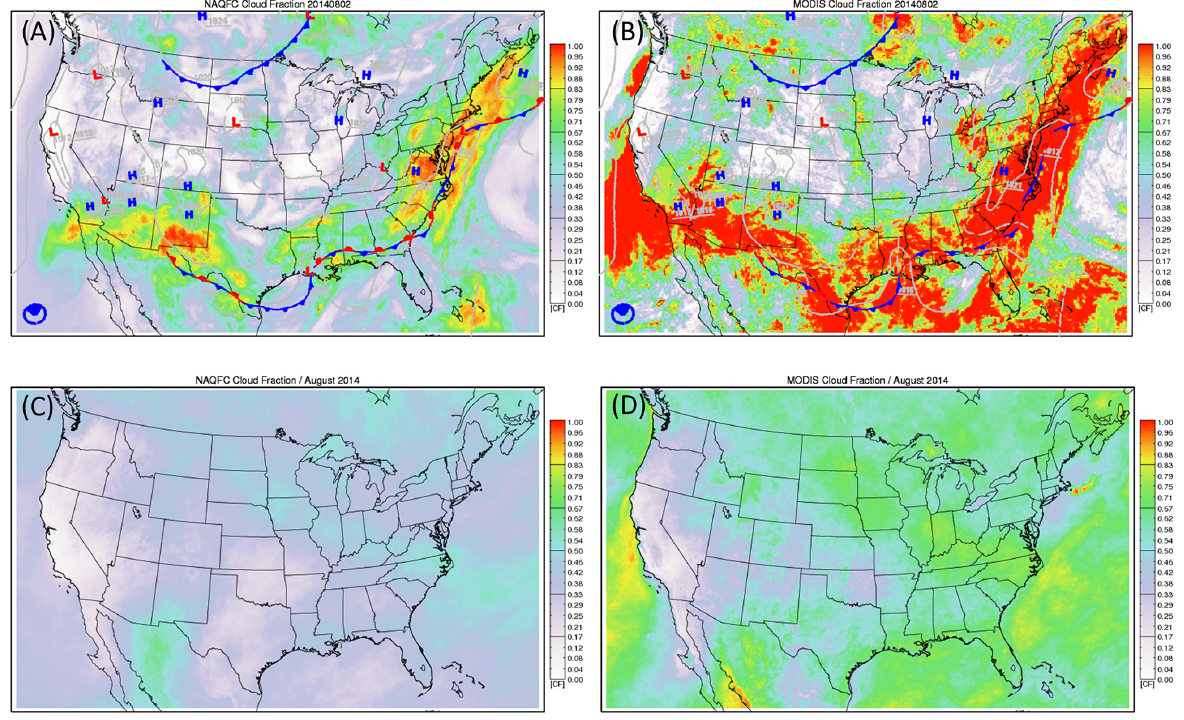
Figure 1. Spatial distributions of cloud fractions on 2 August 2014 from NAQFC (a) and MODIS (b) . NOAA NCEP surface weather chart at 18:00UTC is overlaid. Monthly averaged distributions are also shown for NAQFC (c) and MODIS (d) .